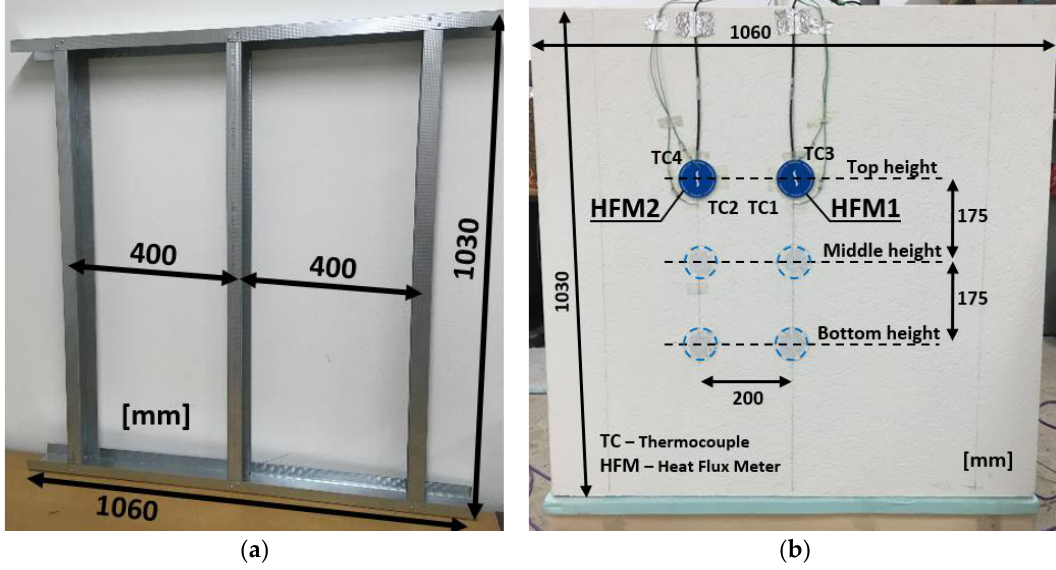
Figure 4. Tested LSF wall sample. ( a ) Steel frame. ( b ) Sensors ’ position (cold surface).